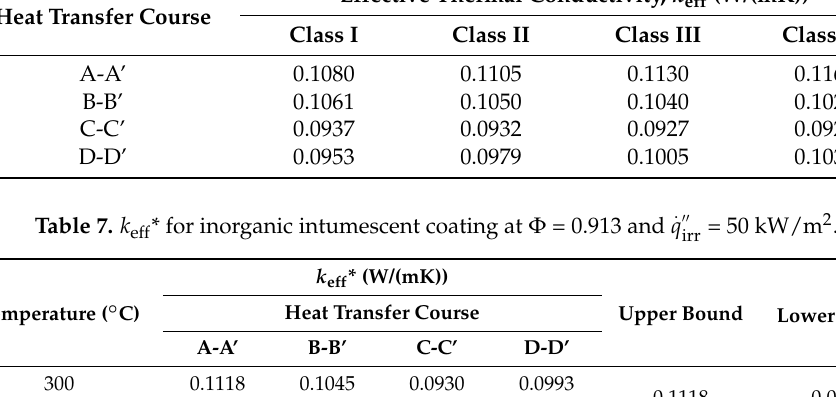
Table 6. Results of supplementary simulations at Φ = 0.913 and